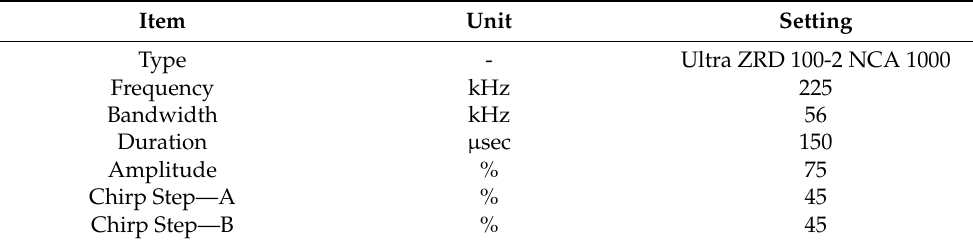
Table 1. Required settings for the pulser–receiver of the transducer.